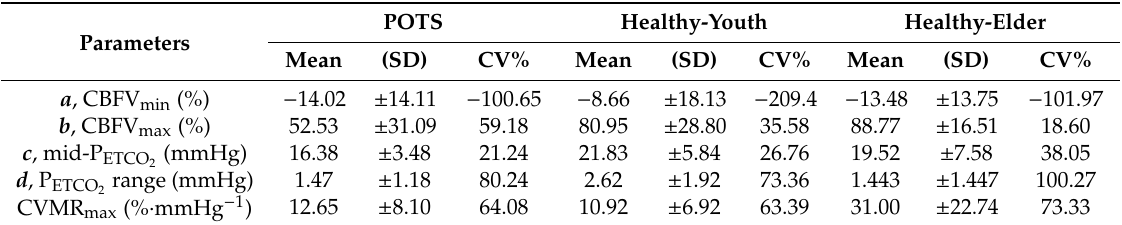
Table 3. Estimation of the logistic function parameters using curve-fitting Model I for three